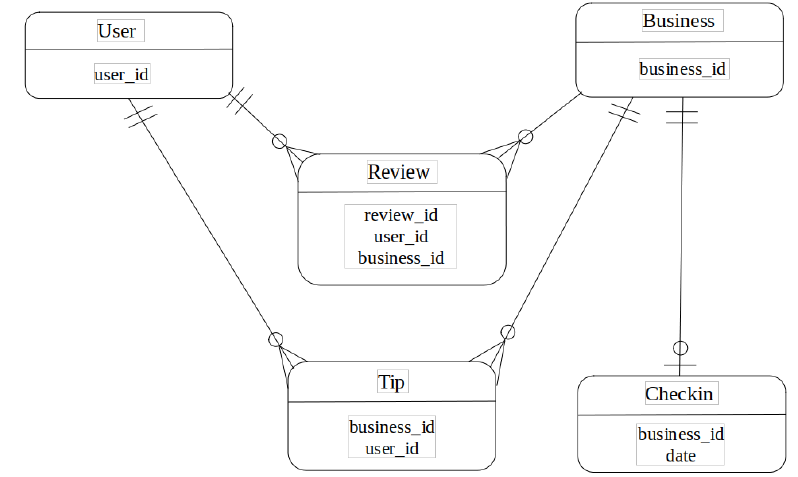
Figure 1. The entity relationships and associated keys.